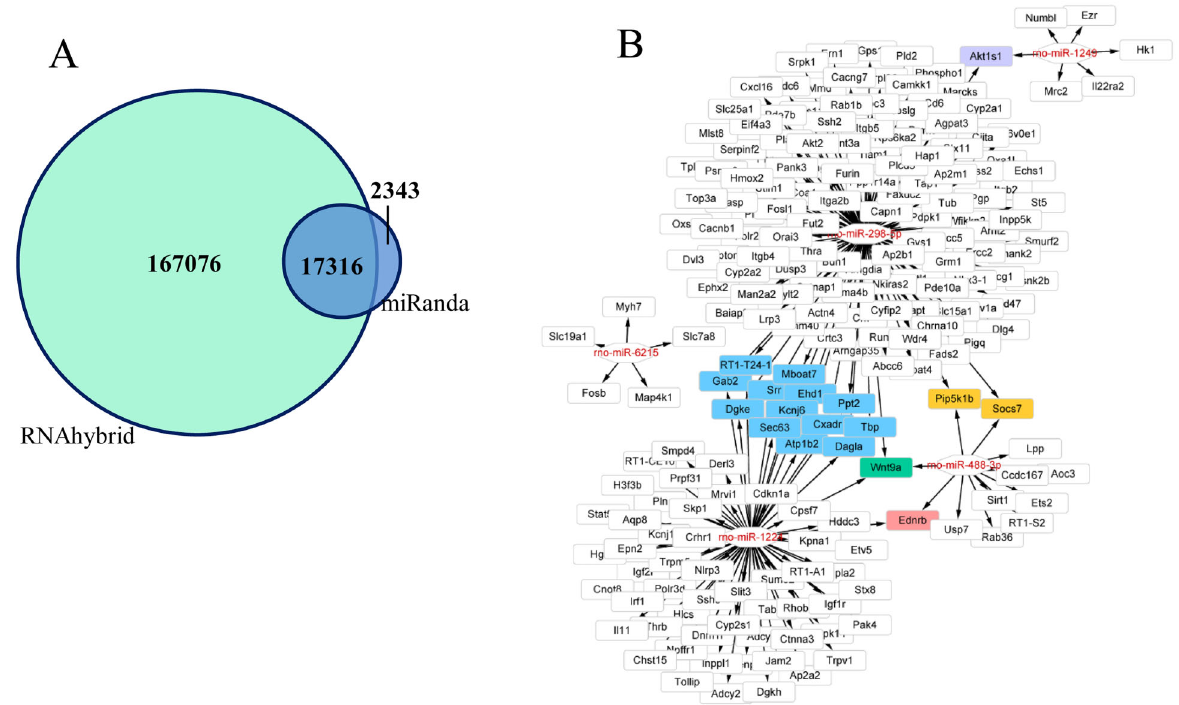
Figure 2. Target gene prediction of the differentially expressed microRNAs. A , Signi fi cantly differential expression of miRNA target gene prediction; B , Five most signi fi cantly differentially expressed miRNA target gene predictions; blue represents the common target gene of rno-miR-1224 and rno-miR-298-5p; purple represents the common target gene of rno-miR-1249 and rno-miR-298-5p; yellow represents the common target gene of rno-miR-488-3p and rno-miR-298-5p; red represents the common target gene of rno-miR-1224 and rno-miR- 488-3p; green represents the common target gene of rno-miR-1224, rno-miR-488-3p, and rno-miR-298-5p.